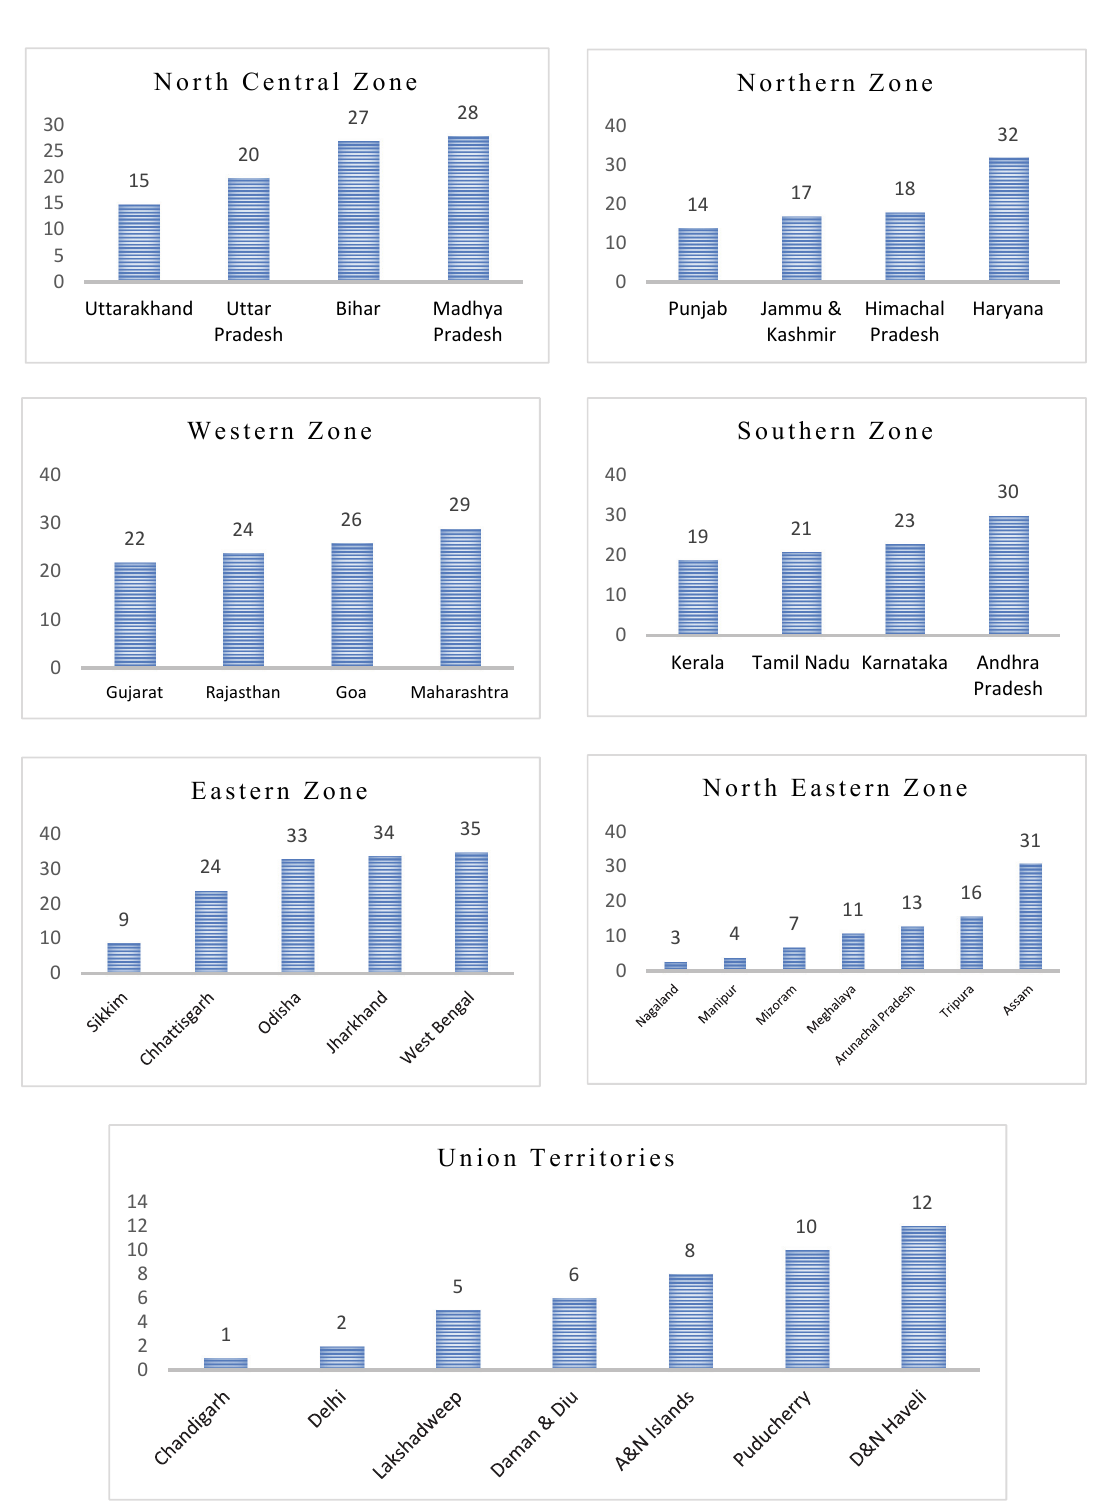
Fig. 3. Ranks of Indian States/UTs according to zonal